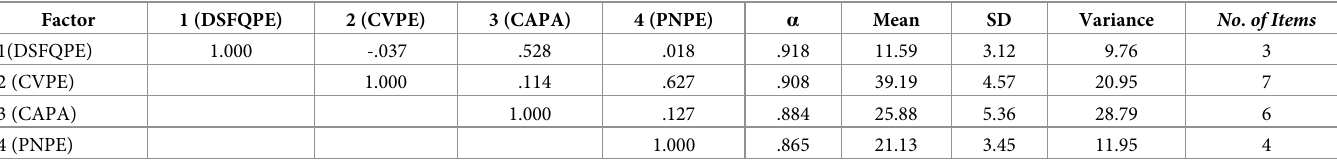
Table 5. Inter-factor correlation, Cronbach’s alpha and descriptive statistics for QPE. Factor